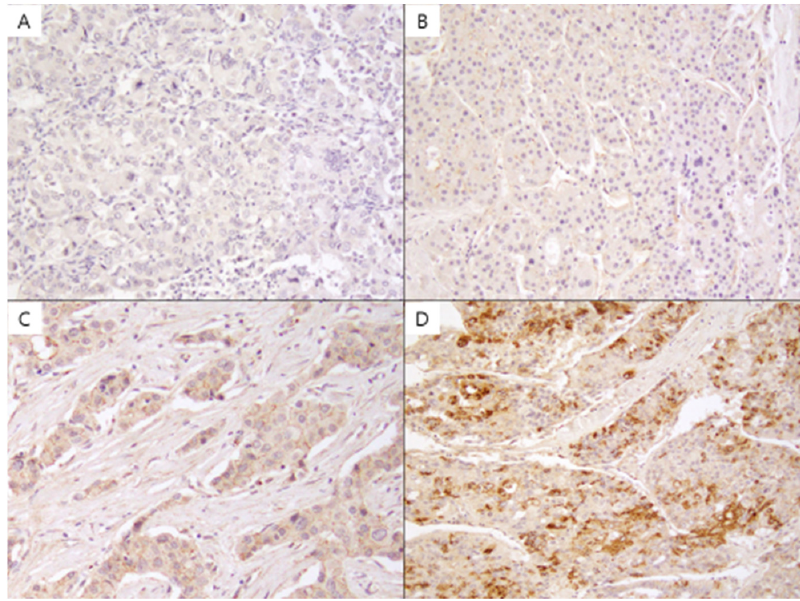
Figure 1. PrP C was immunohistochemically stained, and its intensity was graded as none ( A ), + ( B ), ++ ( C ), and +++ ( D ). Original magnification